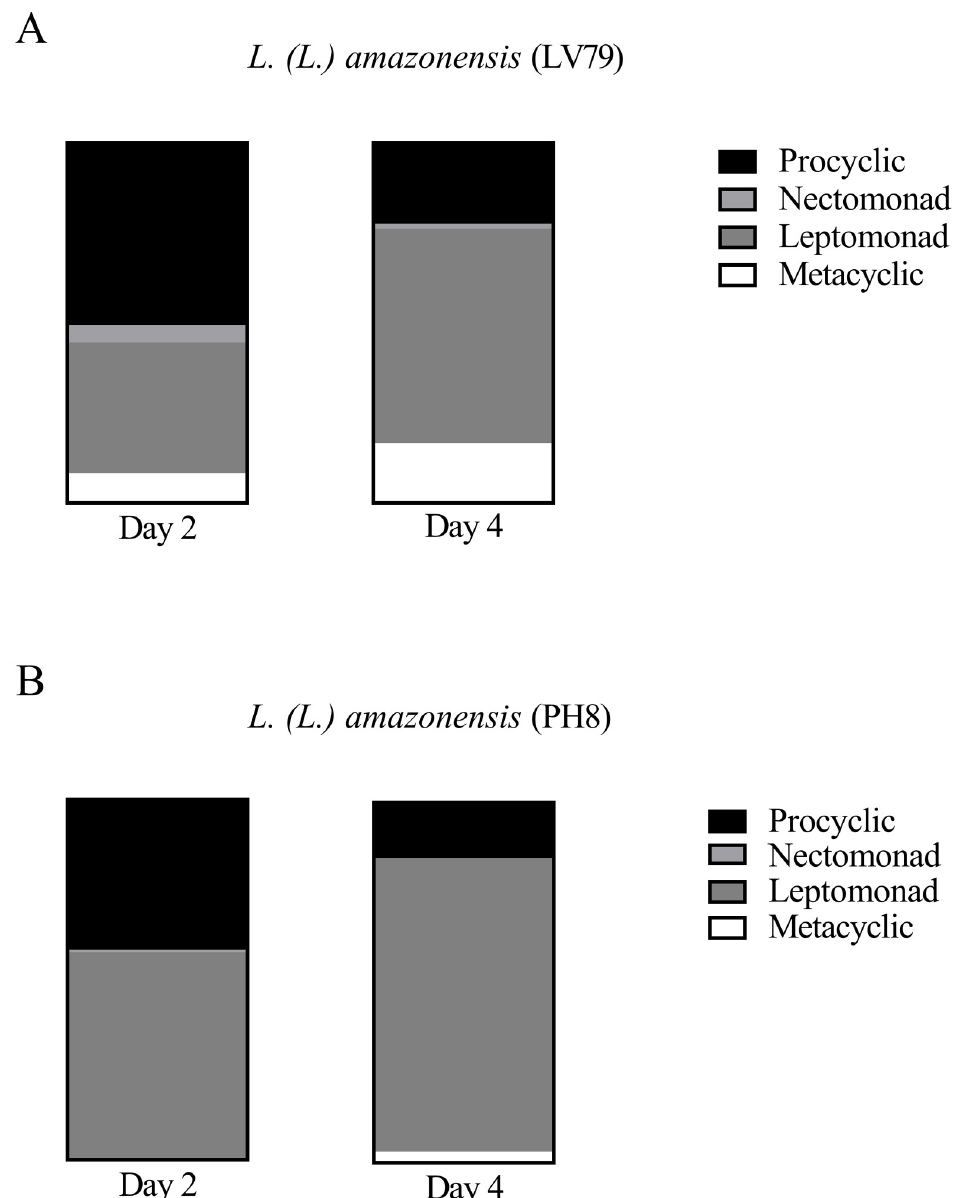
Fig 9. Proportion of procyclics, nectomonads, leptomonads and metacyclics in log phase (day 2) and early stationary phase (day 4) cultures of L . (L . ) amazonensis LV79 (A) and PH8 (B) strains. Flagellum and body length from 150 parasites were measured using ImageJ and parasites were classified according to